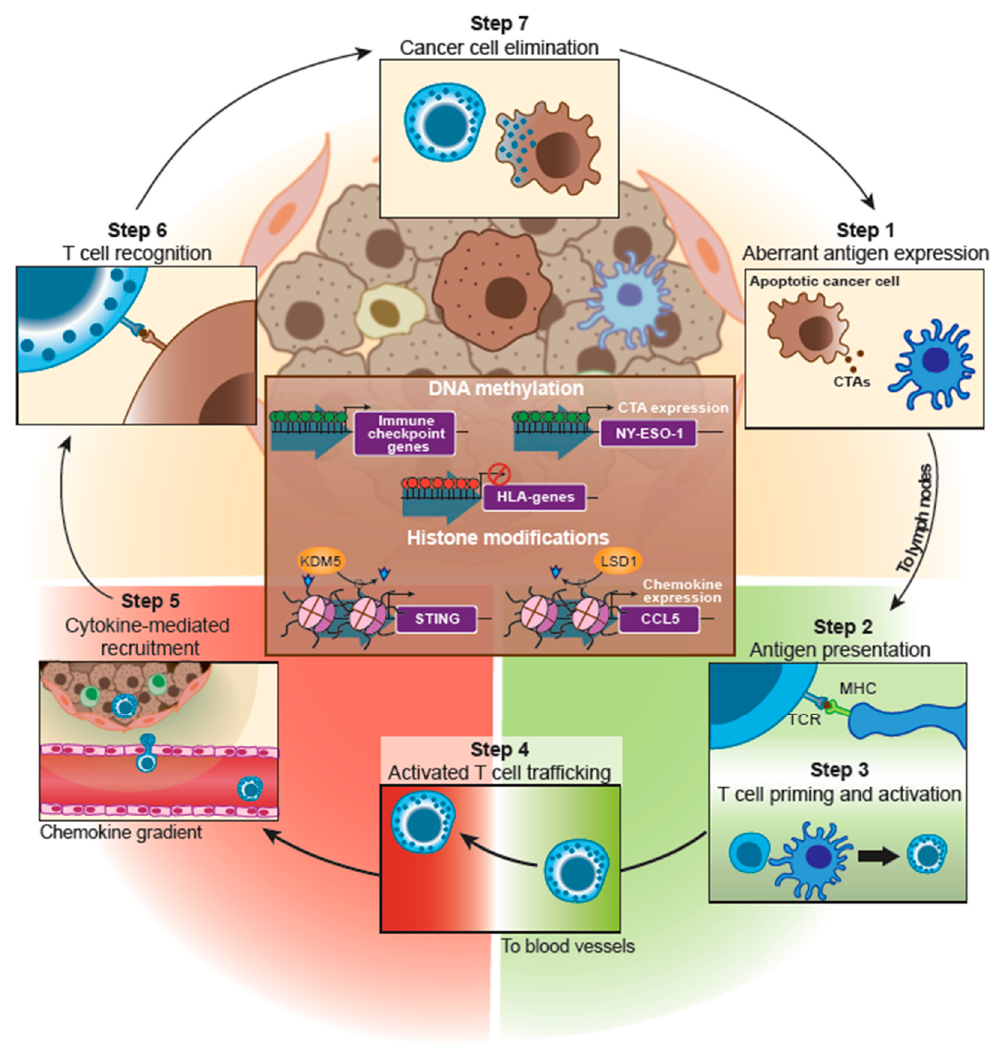
Figure 2. Epigenetic regulation of cancer–immunity cycle in TNBC. This scheme shows epigenetic mechanisms involved in TNBC immune escape (brown square in the middle). It also includes the different steps of the cancer immunity cycle. Scheme based on Chen and Mellman (2013) cancer-cell immunity cycle [23]. Abbreviations: CTAs (Cancer testis antigens), TCR (T-cell receptor), MHC (Major Histocompatibility complex).